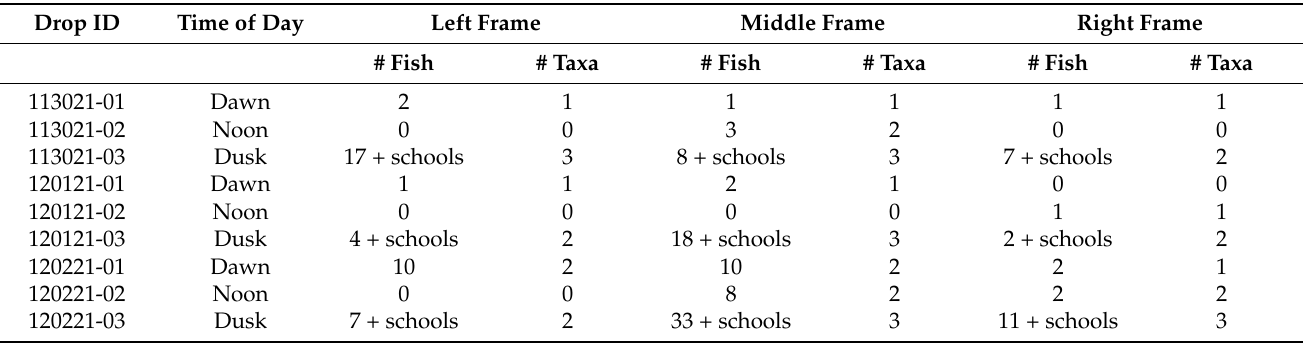
frames of each video deployment (drop